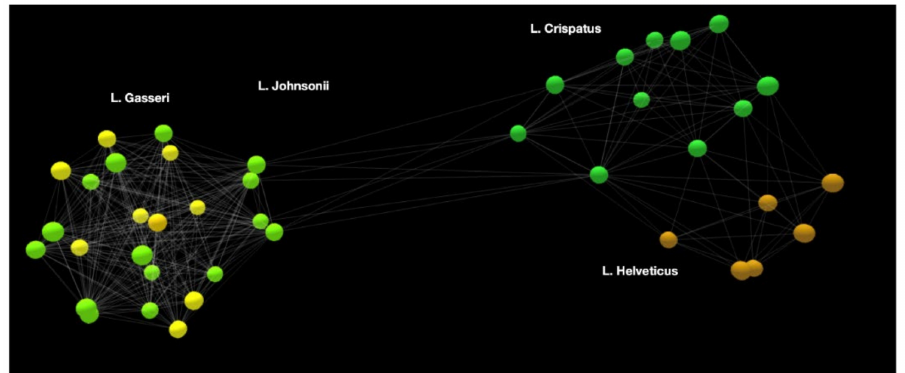
Figure 4. Basic principles of separation by CTCE “Reprinted with permission from Ref. [60]. 2022, John Wiley & Sons”.